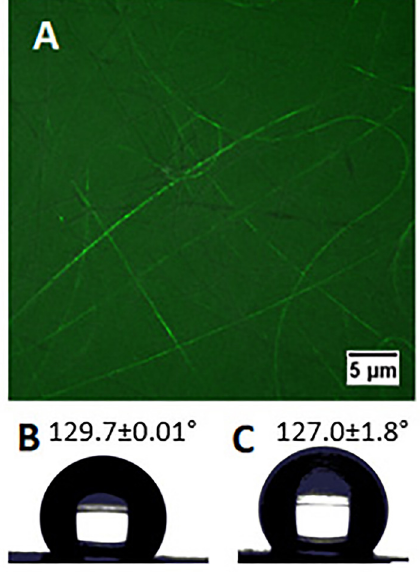
Figure 2. A , Confocal fl uorescence microscopy image of the core-shell electrospun micro fi bers using fl uorescein in the core (scale bar: 5 m m). B and C, images from contact angle meas- urement of PLGA (129.7 ± 0.01°) and VPA/PLGA 127.0 ± 1.80° scaffolds, respectively